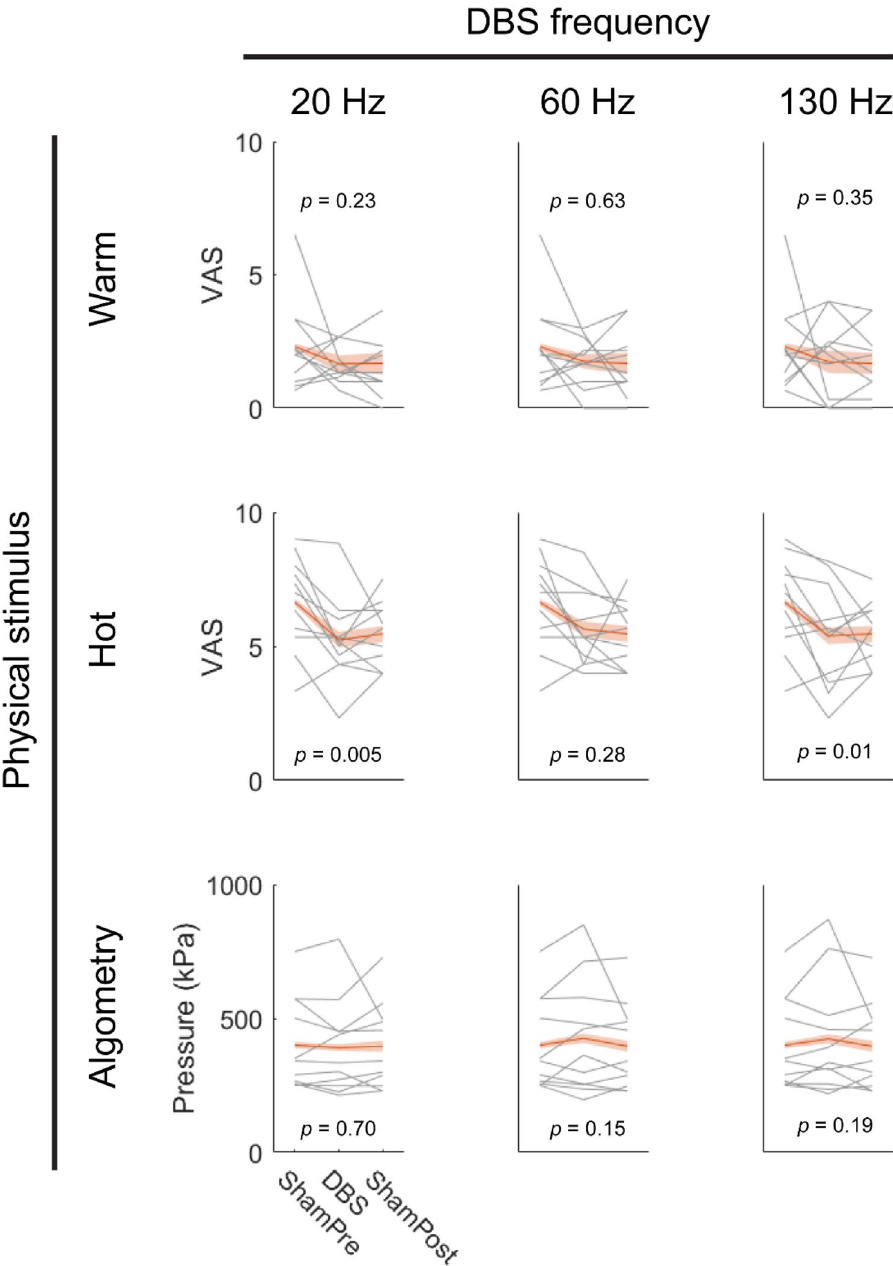
Figure 2. Effects of DBS on perceived pain from warm stimuli, hot stimuli, and mechanical pressure. Gray lines show mean pain scores across arm sites for each subject-implant. Red lines show average across implants with standard error of the mean shaded. Note that intra-subject changes tend to occur across a small range within the visual-analog scale, provided in full for data transparency. n = 99 trials for all analyses shown, with sham trials shared across DBS frequencies. VAS visual analog